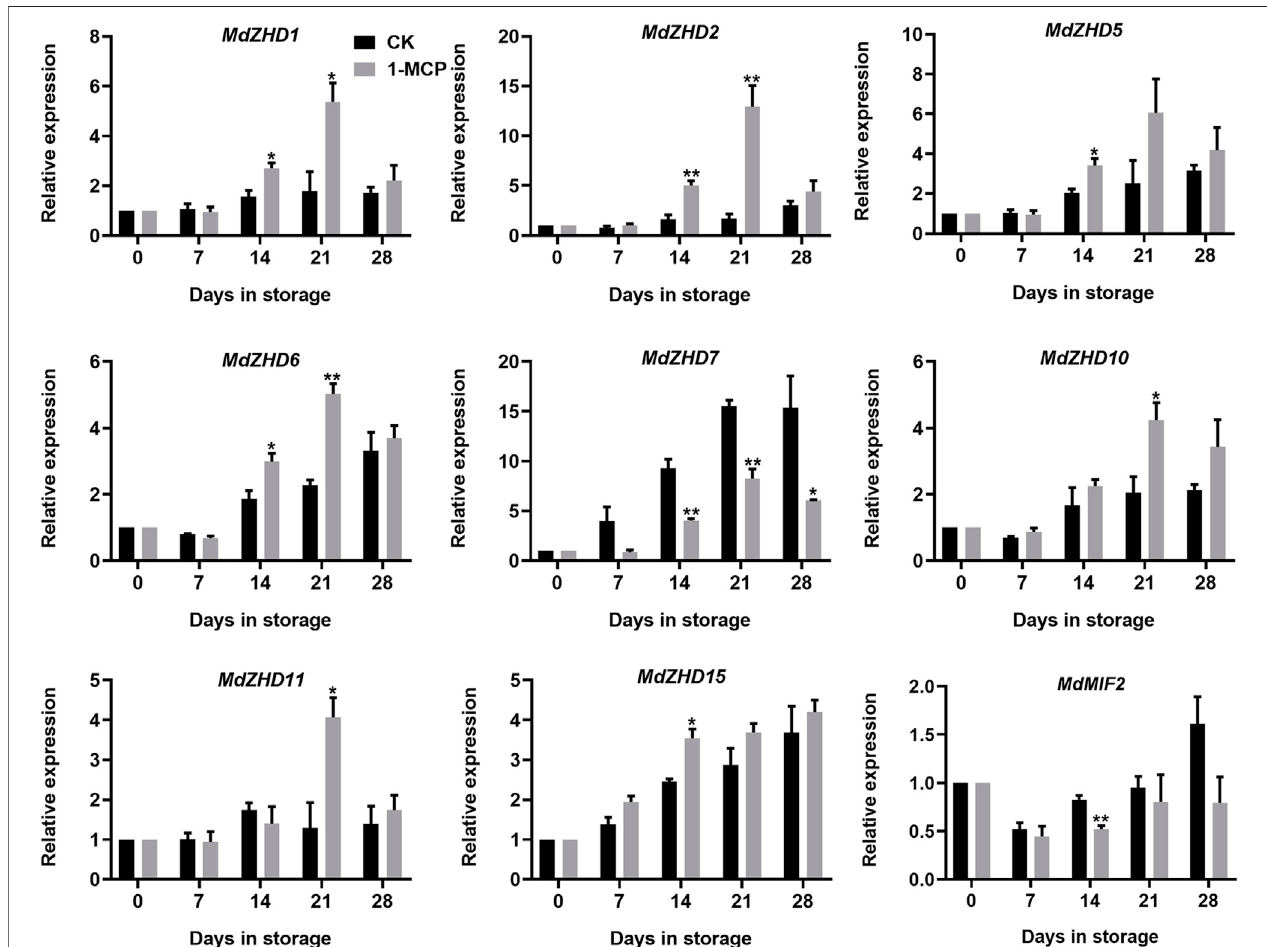
FIGURE 6 | Expression patterns of ZF-HD genes in response to 1-MCP treatment during “ Qinguan ” apple fruit ripening. “ Qinguan ” fruit were treated with 1-MCP (1 μ L L − 1 ) or air (control/CK) for 24 h at 20 ° C. The values of day 0 fruit were set as 1. Black columns and gray columns represent the expression levels of the genes transcripts in control (CK) and 1-MCP treated fruit, respectively. Error bars represent SEs from three biological replicates (* p < 0.05; ** p < 0.01).